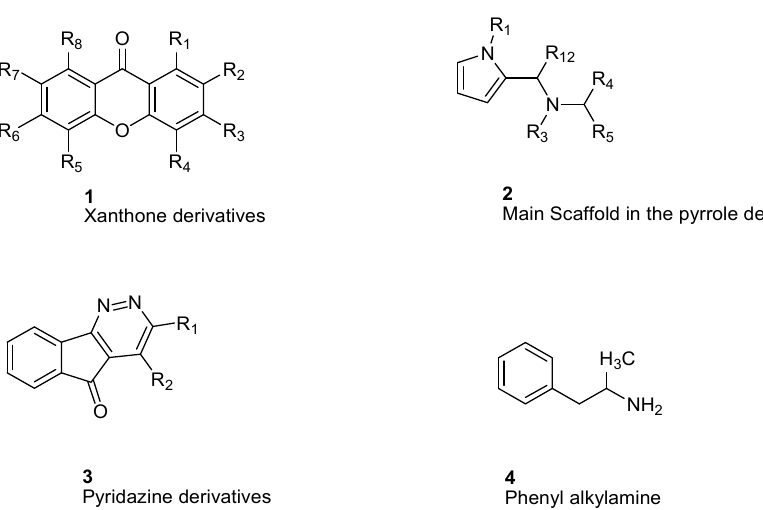
Figure 3. Main scaffolds of Xanthone, Pyrrole, Pyridazine, and Phenyl alkylamine derivatives studied as MAO-inhibitors (R 1 = OH, R 2 = MeO, R 3 = MeO, R 4 = H or OH R 5 = H, R 6 = CHMe 2 , R 7 = NHMe, NMe 2 , NH 2 , R 8 = H).